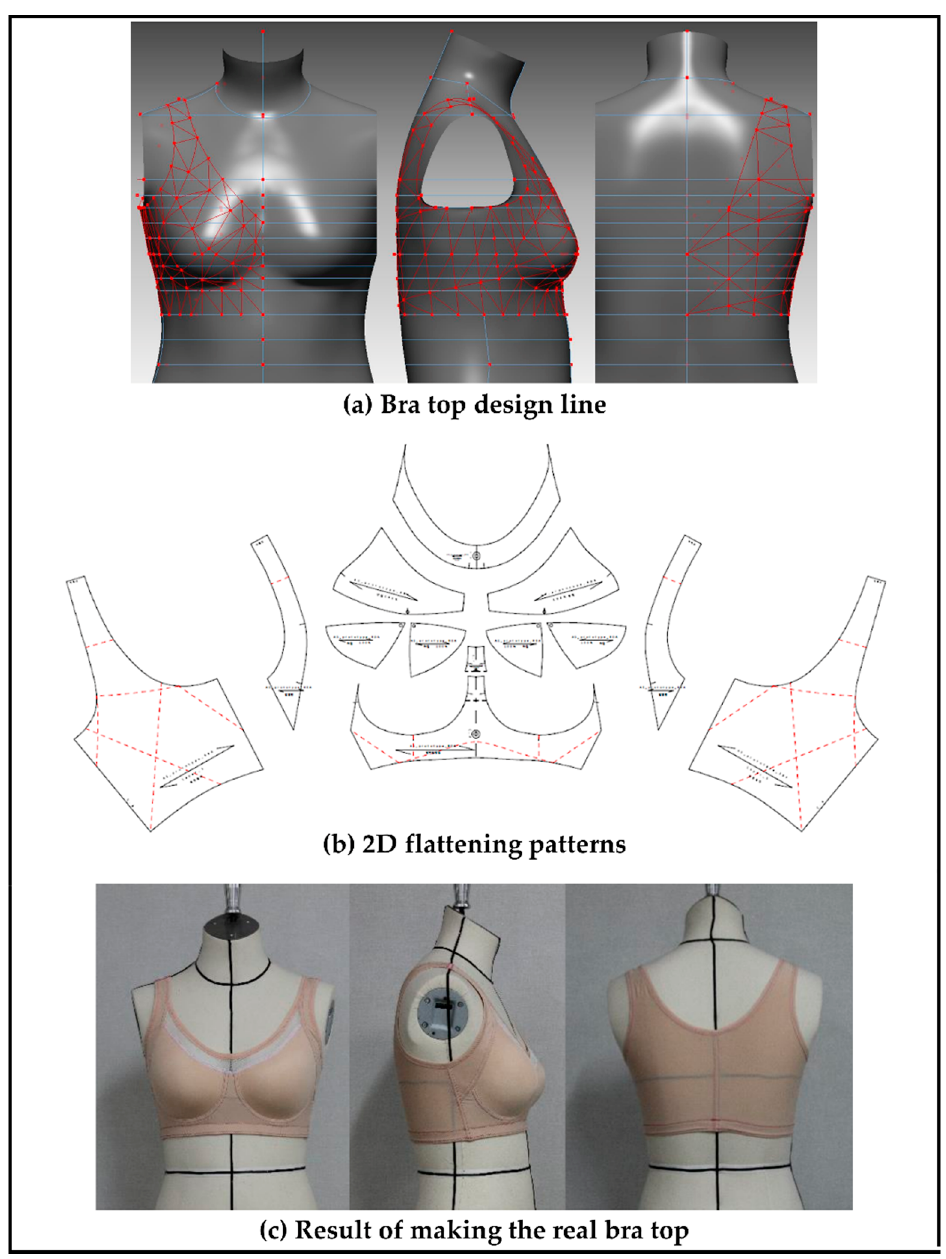
Figure 5. Development of a three-dimensional pattern considering optimal clothing pressure.